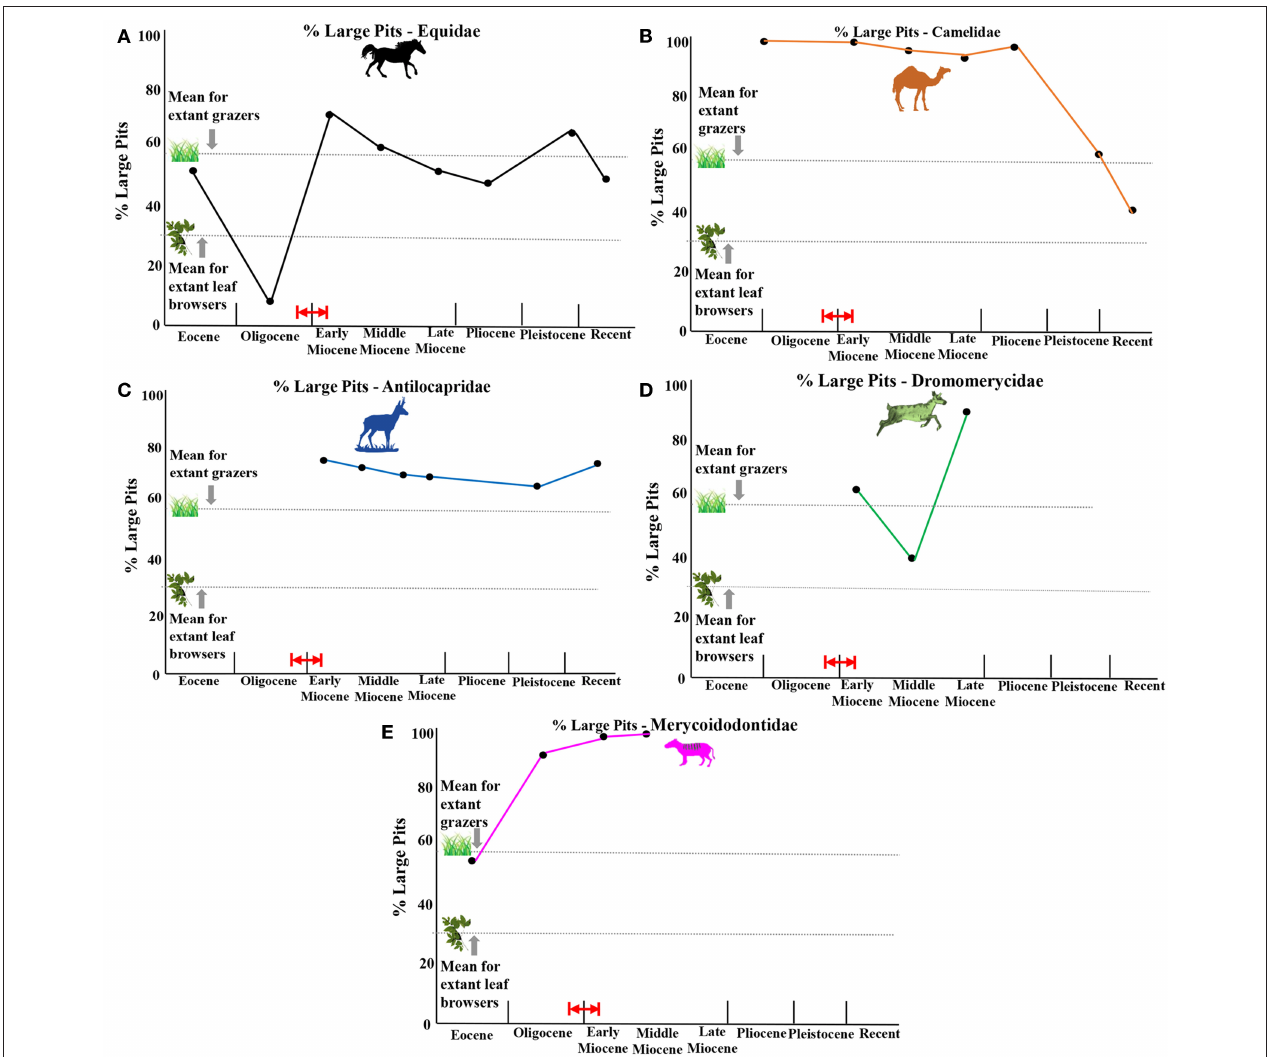
FIGURE 8 | Average percentages of individuals per taxa in each time period that display large enamel pits (averages for extant ungulates from Semprebon, 2002). (A) equids, (B) camelids, (C) antilocaprids, (D) dromomerycids, (E) merycoidodontids. Red arrow and red lines indicate probable timing of first availability of grass in the North American Great Plains Region by ∼ 22 million years ago (earliest Miocene), but possibly by even about 26 million years ago (latest Oligocene) based on phytolith data from Strömberg